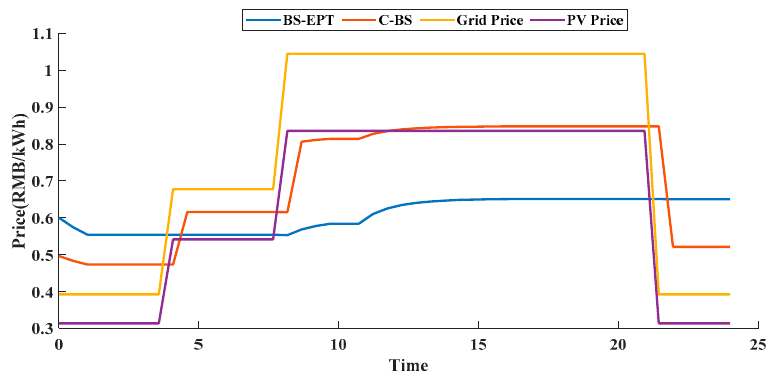
Figure 12. Charging Power and SOC of Energy Storage System.